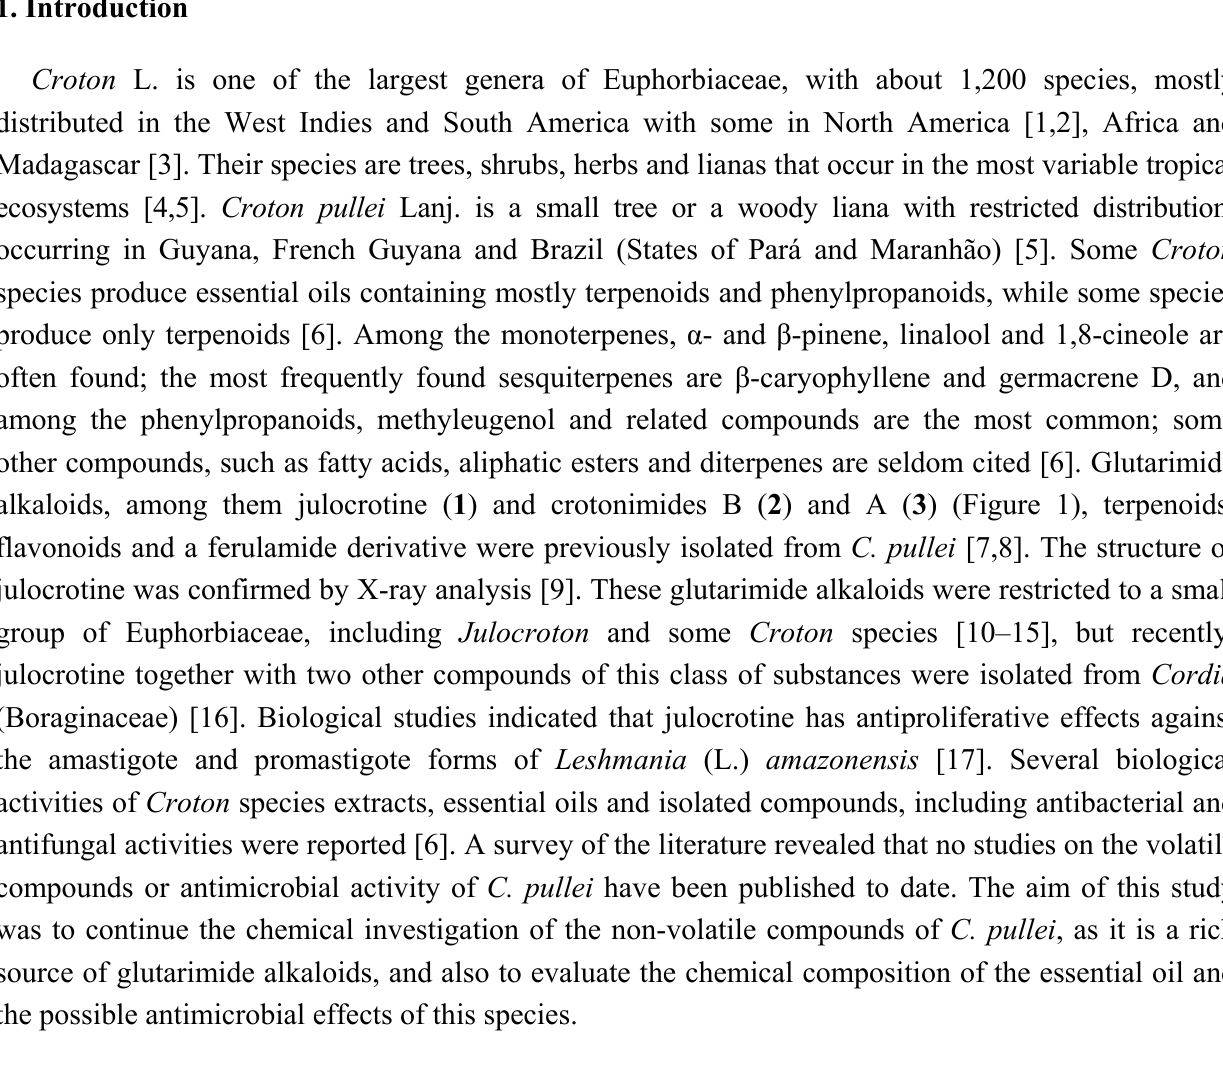
Figure 1. Structures of the glutarimide alkaloids from Croton pullei